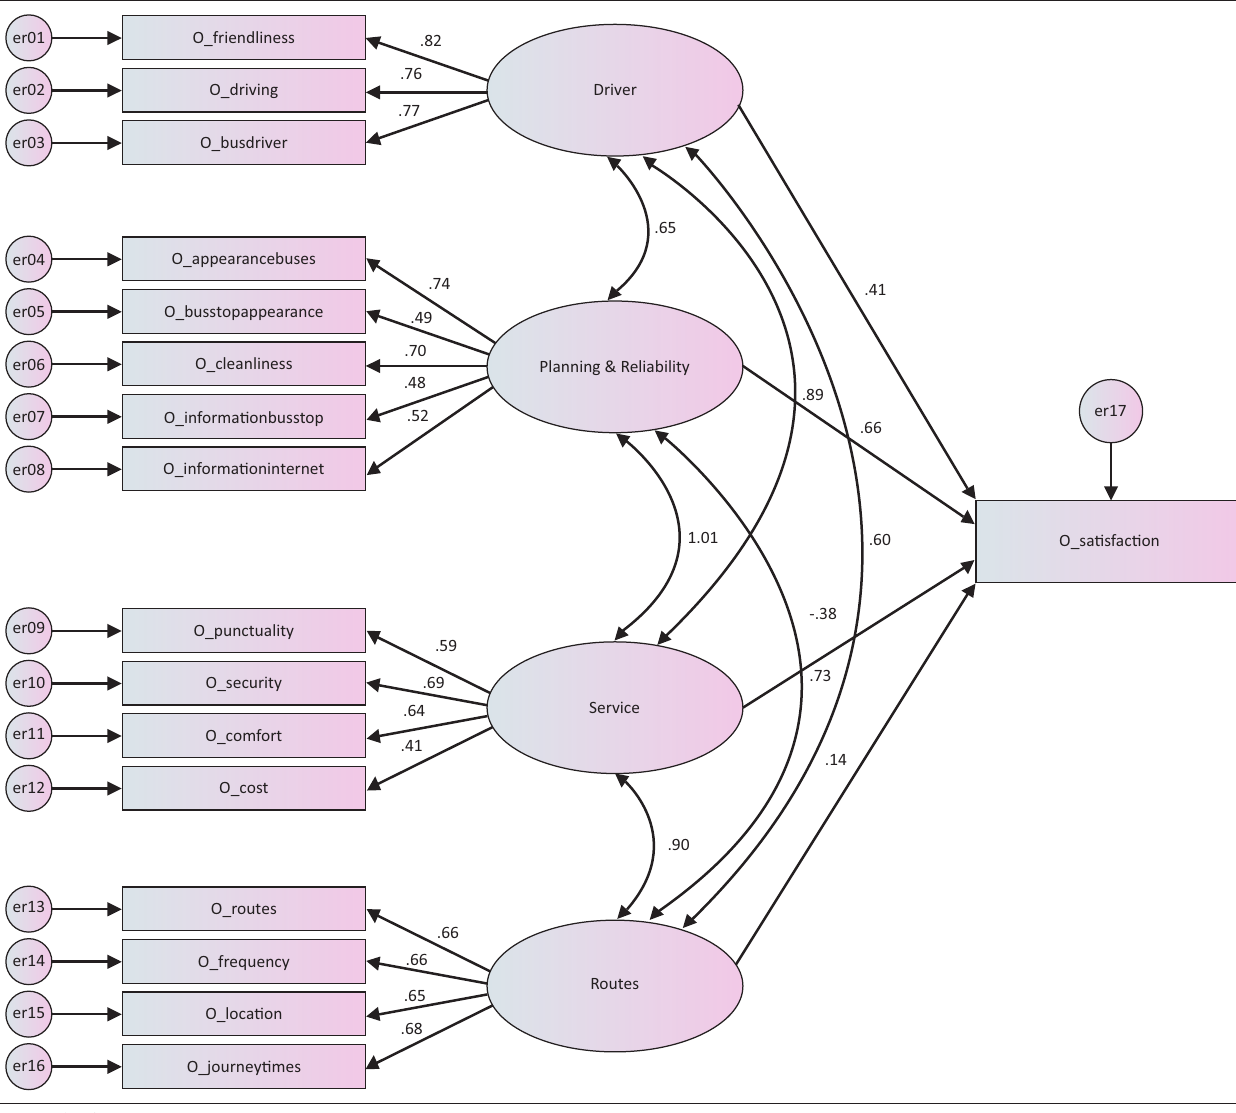
FIGURE 1: Initial structural equation model (with standardised estimates). TABLE 4: Variable ‘purpose’. Service quality Underlying area or construct